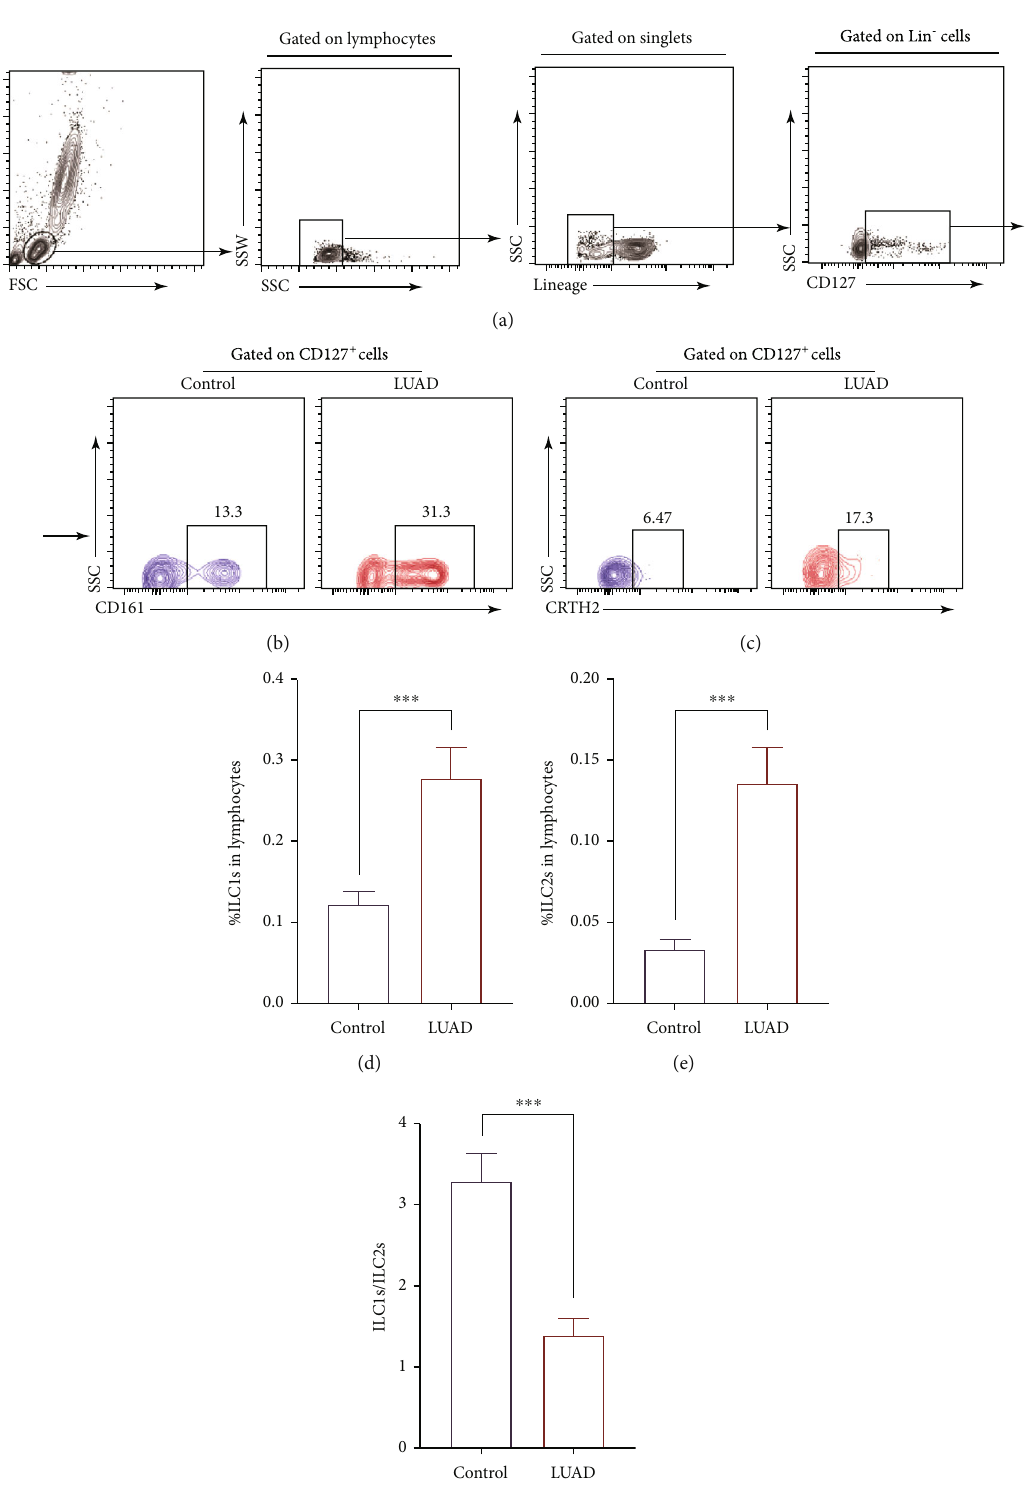
Figure 2: The immune balance of ILC1/ILC2 was biased towards ILC2. (a) Gating strategy of lineage - CD127 + cells. Gating strategy of ILC1 (b) and ILC2 (c) from patients and healthy controls. Frequency of ILC1 (d) and ILC2 (e) of blood samples from patients and healthy controls. (f) The ratios of ILC1s/ILC2s in blood samples from patients with LUAD and healthy controls. Data shown were represented as mean ± SD (all samples were measured in triplicate). ∗∗∗ P < 0 : 001